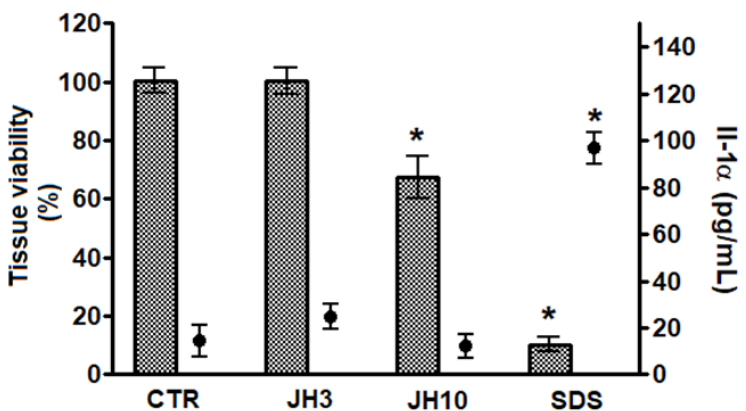
Figure 3. Compounds JH3 and JH10 in vitro evaluation of skin irritation using Episkin TM model. Results are expressed as mean ± standard deviation, samples were tested in two independent experiments using three tissues for each chemical, positive, or negative control. (*) p < 0.05 when compared to negative control. 5 µ L of sterile water was applied onto the surface of the epidermis, followed by the application of 26 mg/cm 2 of the formulations of JH3 and JH10; sodium dodecyl sulfate (SDS) (5% in water) and PBS were used as positive and negative (CTR) controls, respectively. Both controls were applied topically (26 mg/cm 2 ).